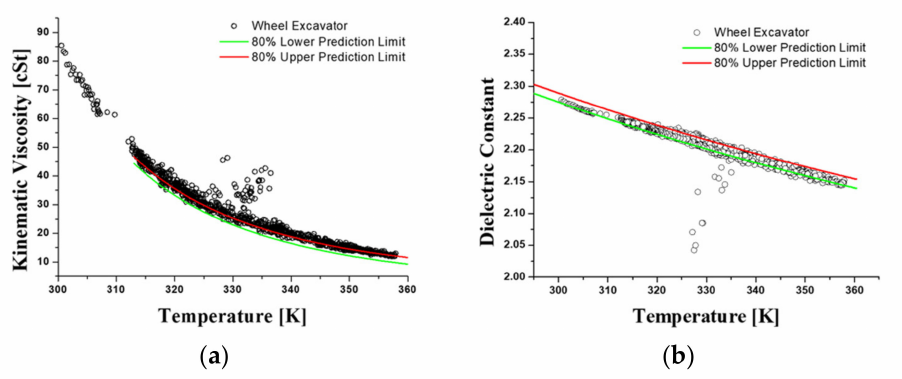
Figure 9. The raw excavator data during one operating day. ( a ) Kinematic viscosity. ( b ) Dielectric